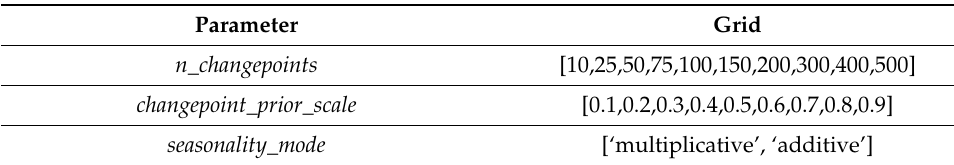
Table 1. Grid parameters of Facebook-Prophet.